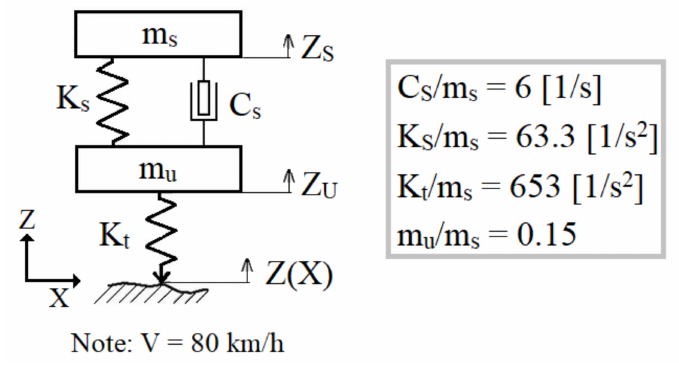
Figure 1. The quarter-car system in the IRI calculation